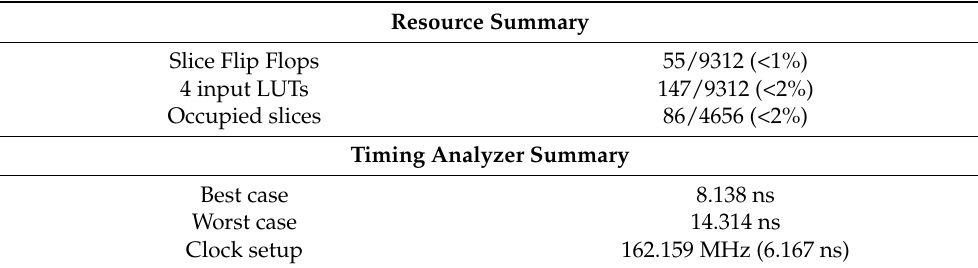
Table 3. Overall system resource and time summary.